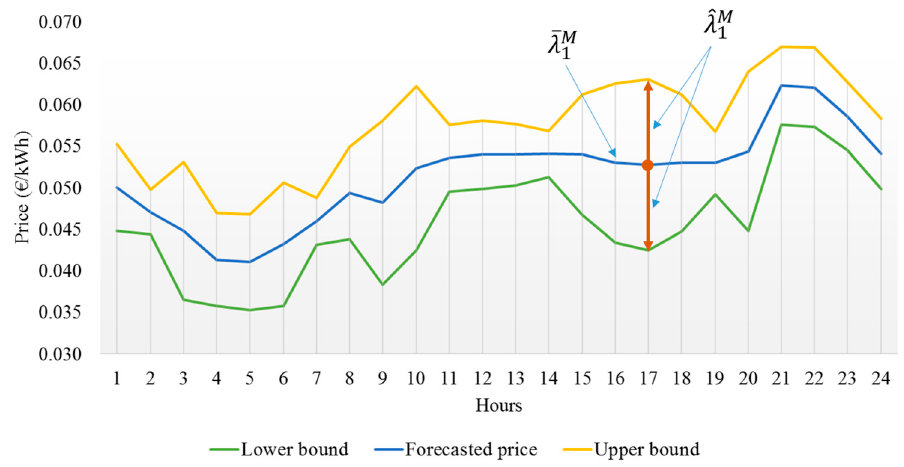
Figure 6. Upper and lower bounds of price values at node 1.